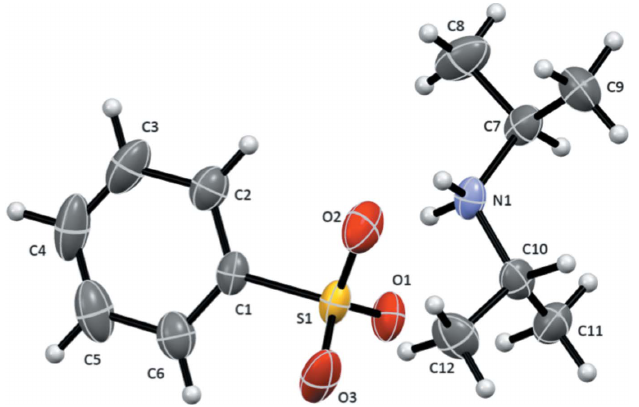
Figure 2 Partial packing diagram showing the hydrogen-bonding interactions. Only H atoms involved in the intermolecular interactions are shown. Symmetry codes: (a) (cid:3) x + 1, y (cid:3) 1 , (cid:3) z + 3 ; (b) x , (cid:3) y + 1 , z (cid:3) 1 ; (c) (cid:3) x + 1, 2 2 2 2 y + 1 , (cid:3) z + 3 . 2 2